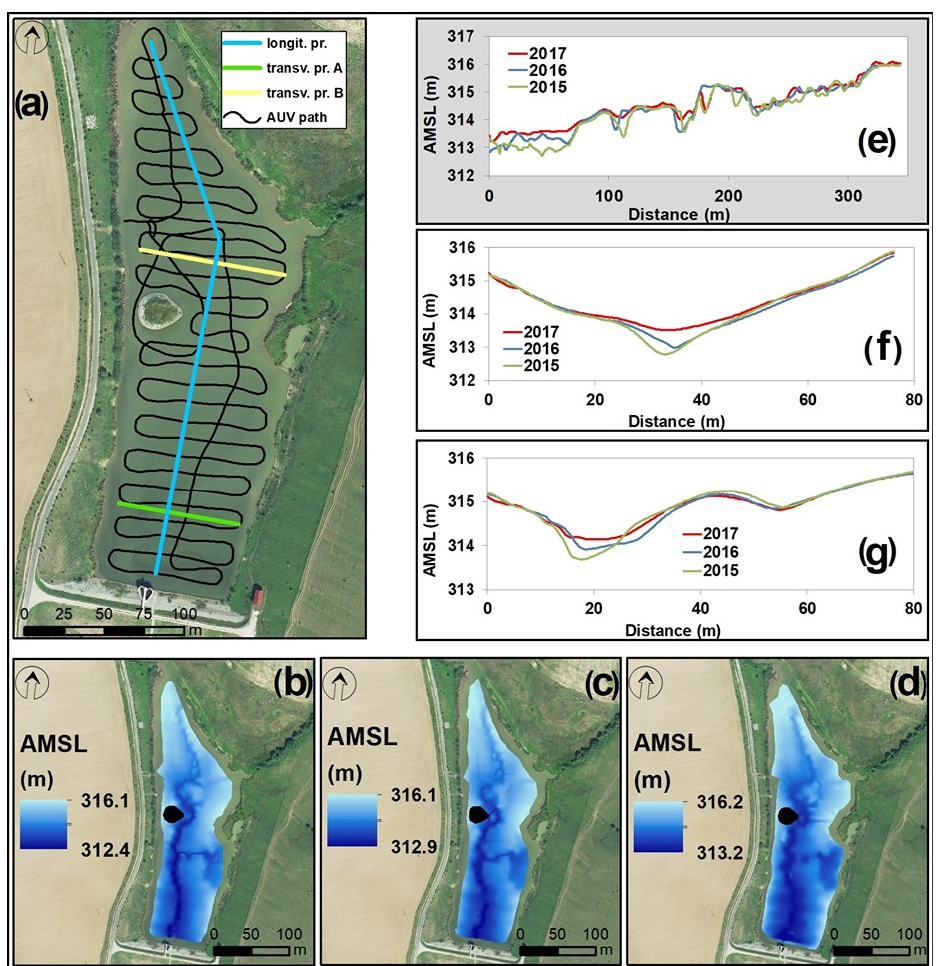
Figure 3. The Svacenický reservoir: ( a ) The autonomous underwater vehicle (AUV) EcoMapper path and longitudinal/transversal profiles; DEM of the reservoir in ( b ) 2015, ( c ) 2016, and ( d ) 2017; Graphs of the bottom’s development—( e ) longitudinal profile, ( f ) transversal profile A, ( g ) transversal profile B.